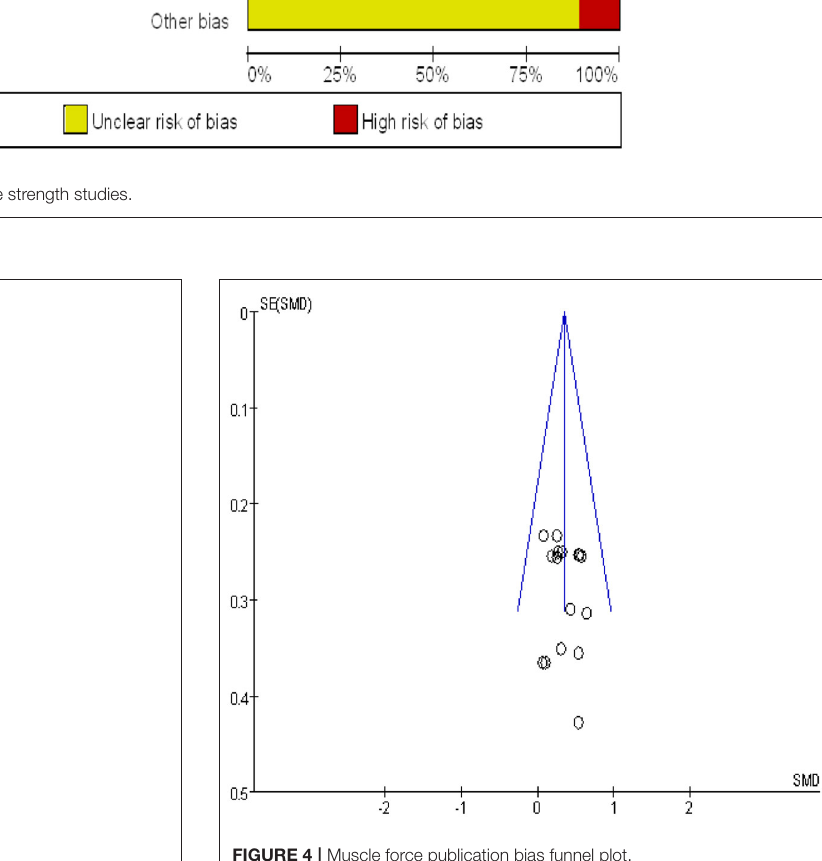
FIGURE 4 | Muscle force publication bias funnel